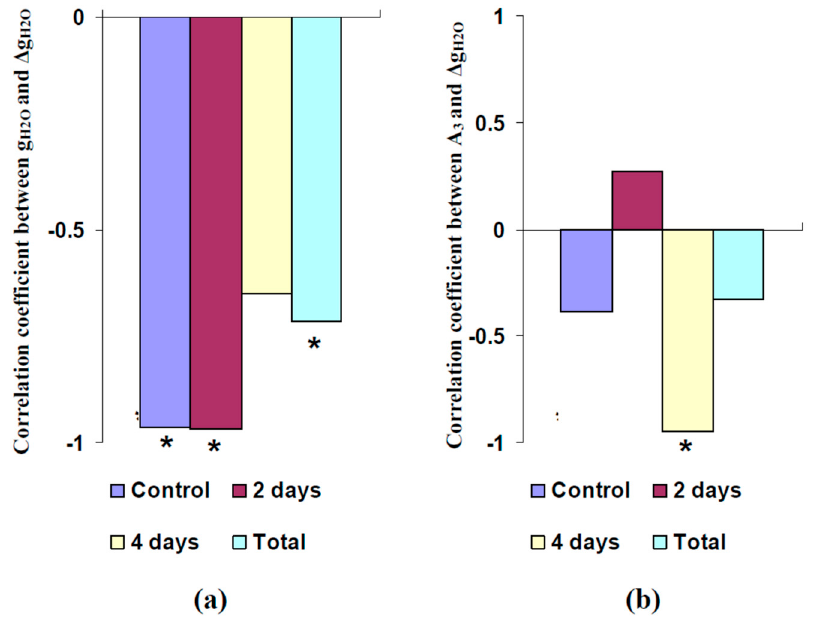
Figure 7. Correlation coefficients between the leaf stomatal conductance (g H2O ) and its burning- induced changes ( ∆ g H2O ) ( a ) and between the amplitudes of the burning-induced electrical signals in the second mature leaf (A 3 ) and ∆ g H2O ( b ) in control pea seedlings ( n = 6), seedlings after 2 days of soil water shortage ( n = 6), seedlings after 4 days of this shortage ( n = 6), and all investigated seedlings ( n = 18). It was assumed that negative amplitudes corresponded to the hyperpolarization signal. *, the correlation coefficient was